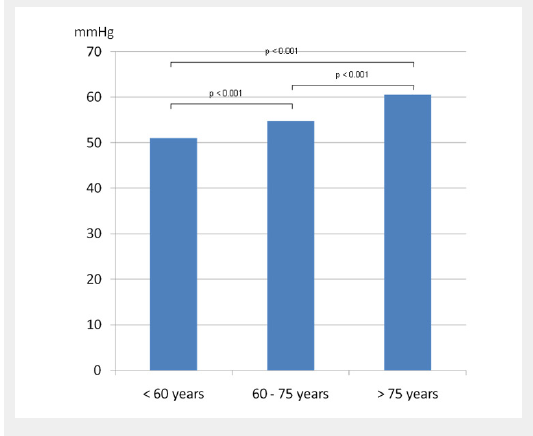
Pulse pressure by different age groups in treated hypertensive patients.